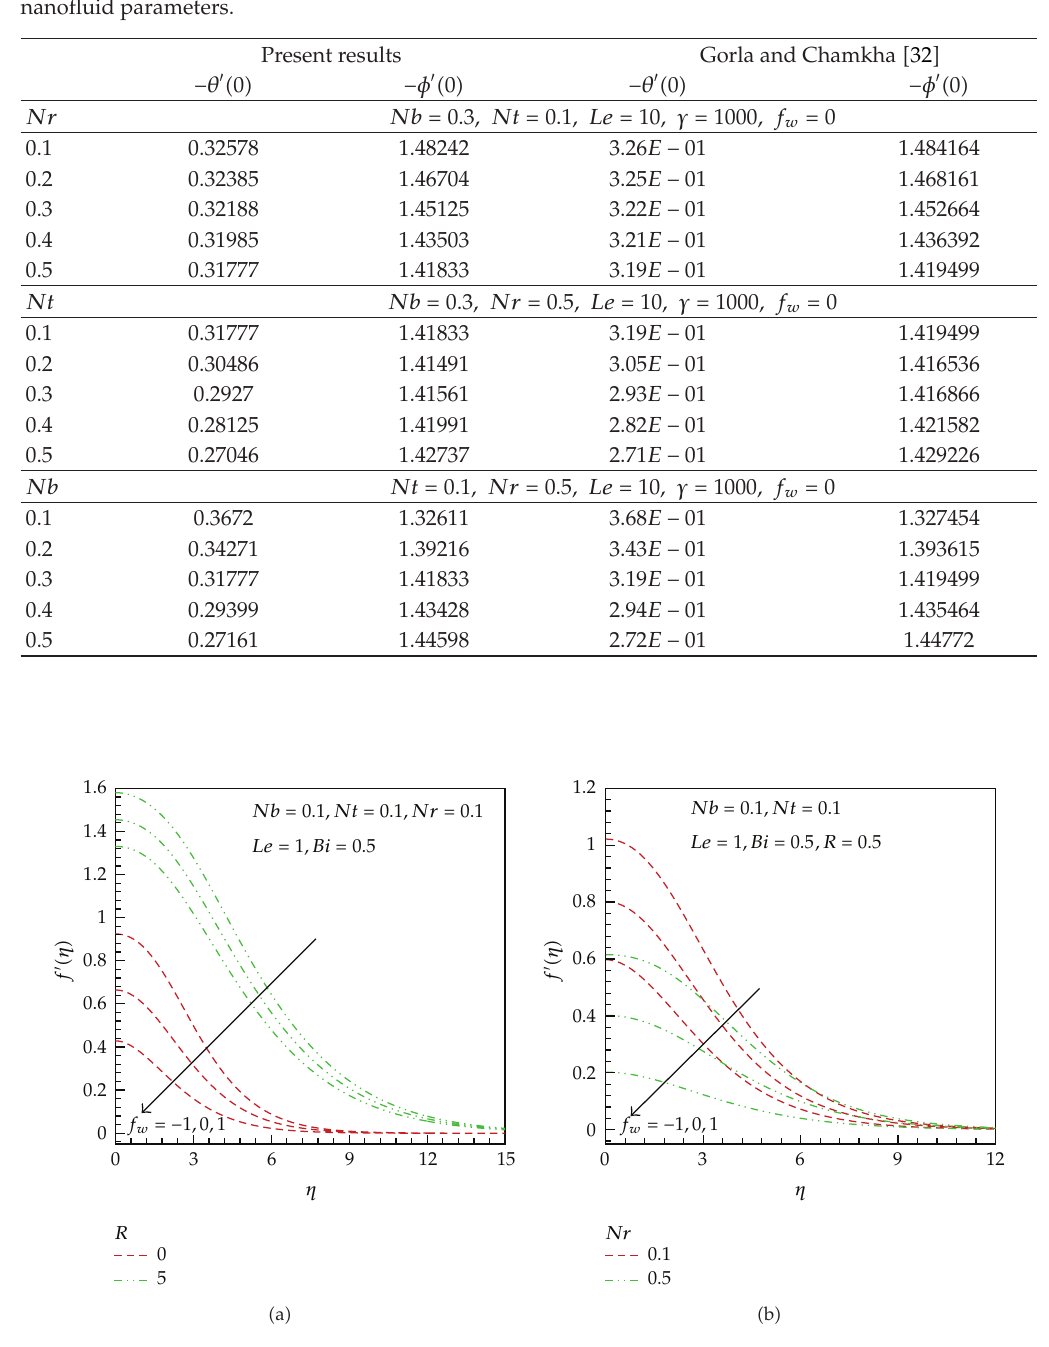
Figure 2: E ff ect of (cid:3) a (cid:4) radiation parameter, (cid:3) b (cid:4) buoyancy ratio parameter on the dimensionless velocity for di ff erent values of suction/injection